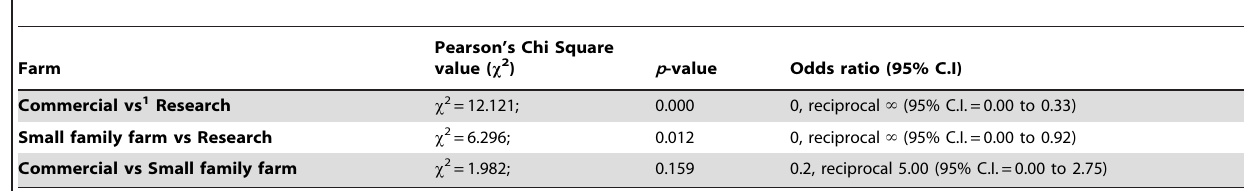
Table 4. Chi-Square analysis of proportion of pigs in each farm setting with Blastocystis DNA detected in the small intestine.